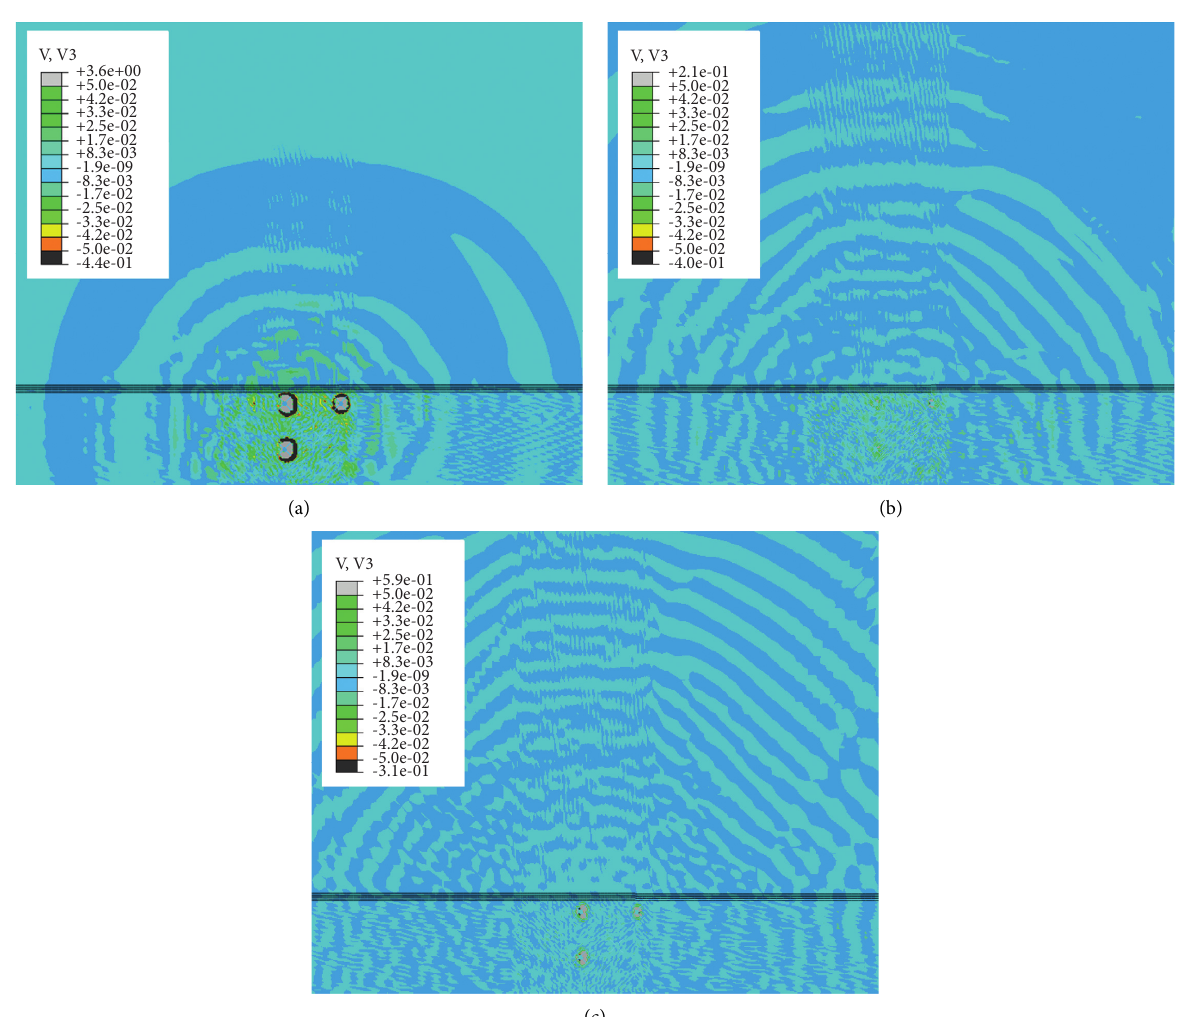
Figure 16: Comparison of the cloud plots of the peak velocity velocities at different times (m/s; for the linear arrangement): (a) 1s, (b) 2s, and (c)